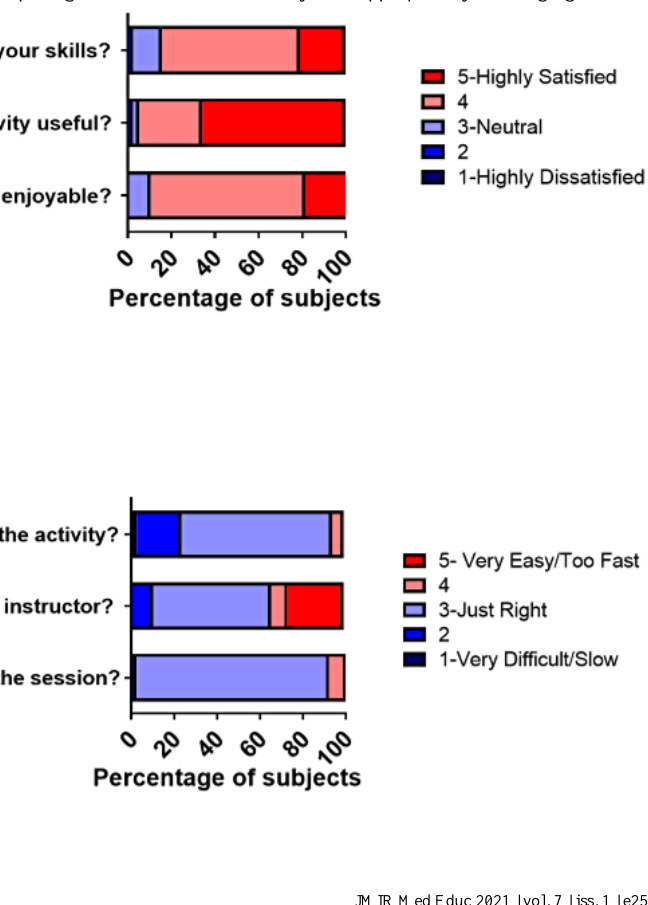
Figure 1. Postactivity satisfaction survey immediately after the lesson. Intervention interns (N=38) were surveyed on a 5-point Likert scale for their impression of the simulation-based learning activity immediately after the session. Panel A: percentage of participants reporting the activity improved their skills, was useful, and enjoyable. Learners found the activity to be helpful and enjoyable. Panel B: percentage of participants reporting the difficulty of the independent portion, following the instructor, and the session’s pacing. Learners found the activity to be appropriately challenging and